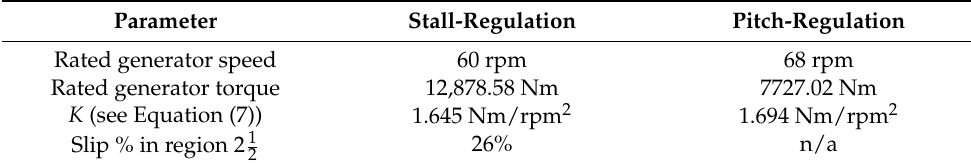
Table 2. OpenFAST variable-speed generator model inputs.